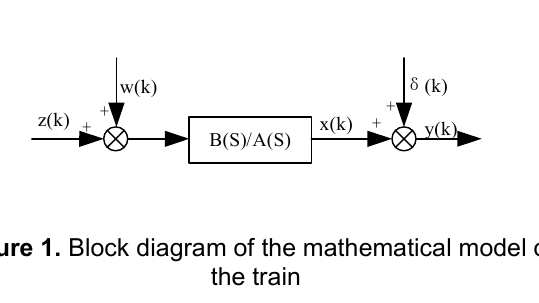
Figure 2. Schematic diagram of the linear active disturbance rejection controller